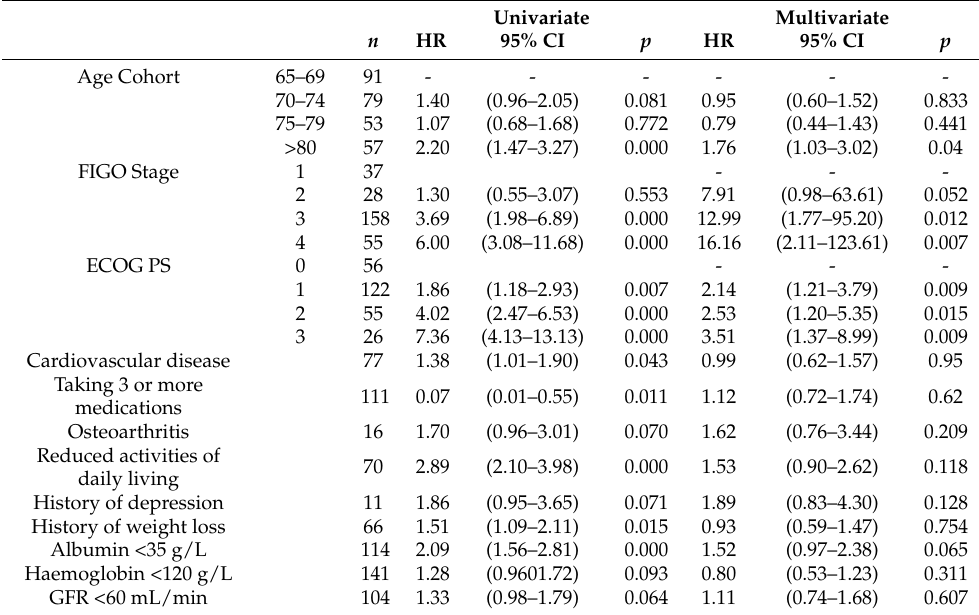
Table 4. Univariate and multivariate analysis of factors associated with poorer overall survival.